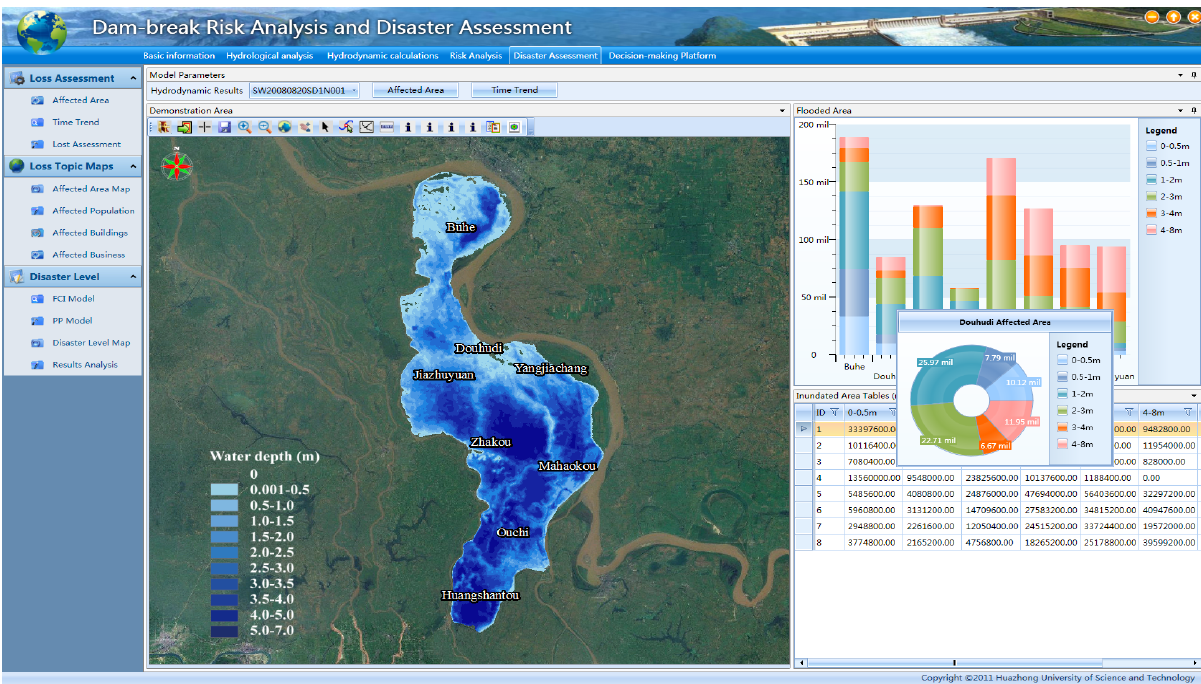
Fig. 12. Interface of submerged condition analysis in quantitative flood damage estimation module.